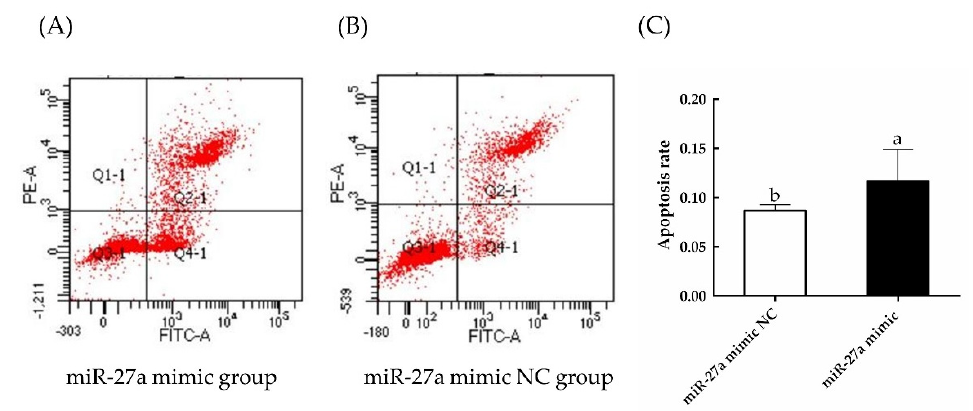
Figure 9. The effects of transfection of an miR-27a mimic on apoptosis were monitored by flow cytometry. The rate of apoptosis was measured by annexin V − FITC and PI staining of cells transfected with a miR-27a mimic ( A ) or a NC construct ( B ). ( C ) Quantification of the flow cytometry results from panels ( A , B ). The different small letters (a, b) in the same graph indicate that the difference between groups is statistically significant ( p < 0.05).